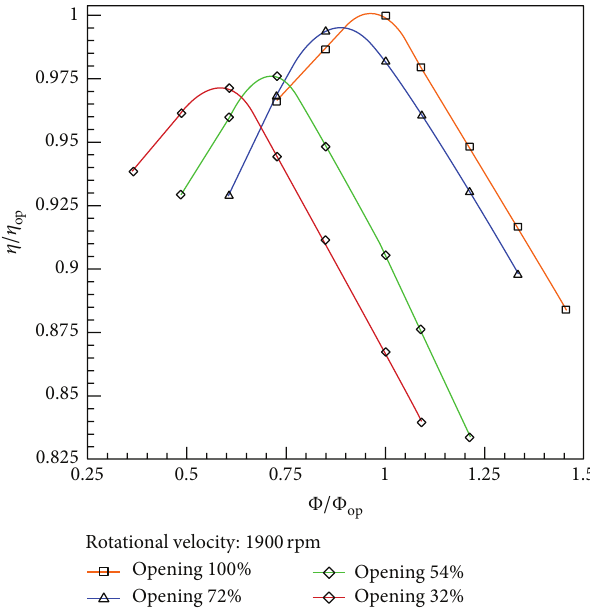
Figure 4: Produced power.